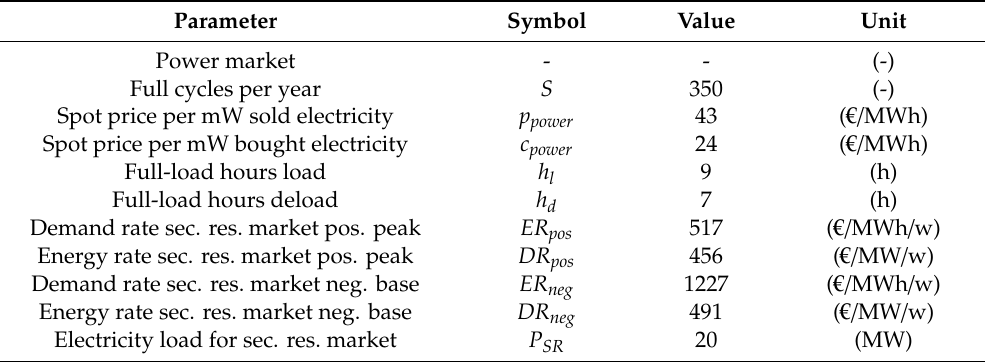
Table 5. Power market-related parameter values assumed.